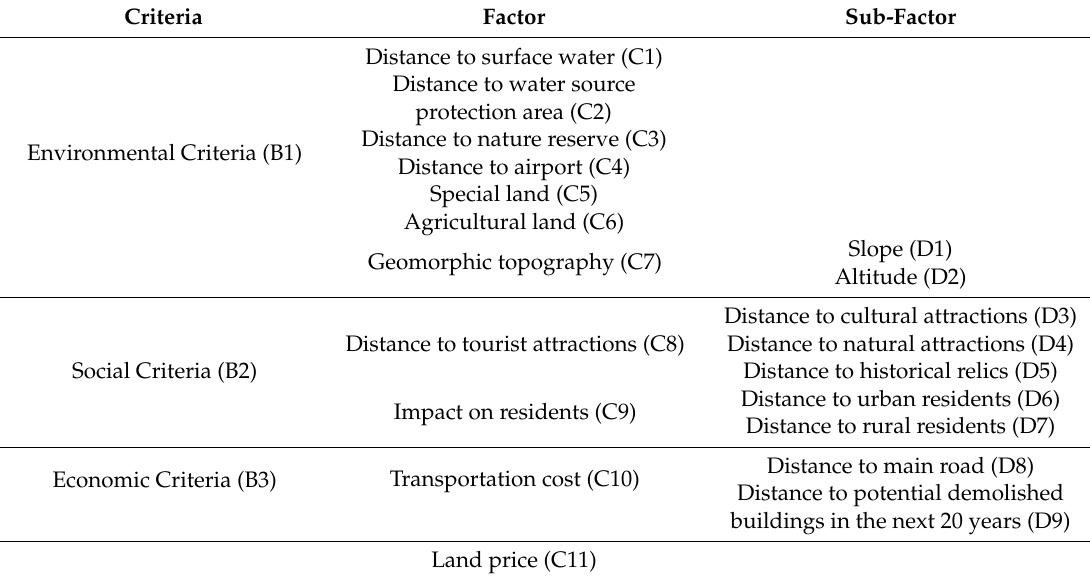
Table 2. Factors for construction waste landfill site